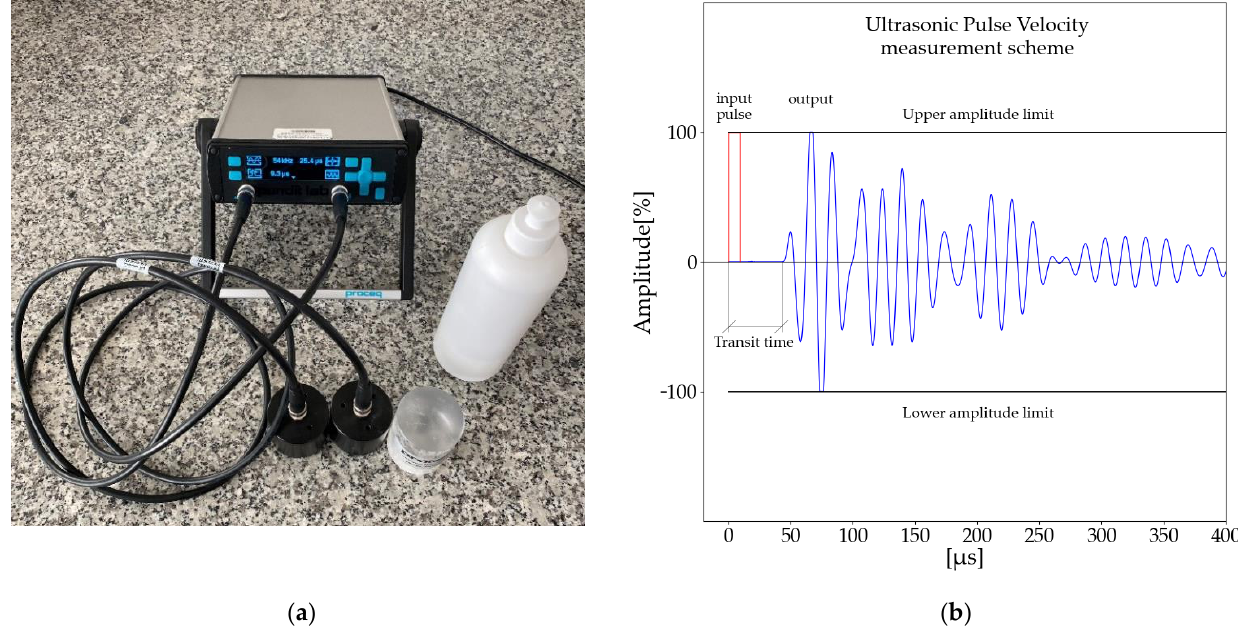
Figure 2. Measuring device: ( a ) Pundit Lab Plus Device, Transducers, Calibration rot; ( b ) UPV test measurement scheme.